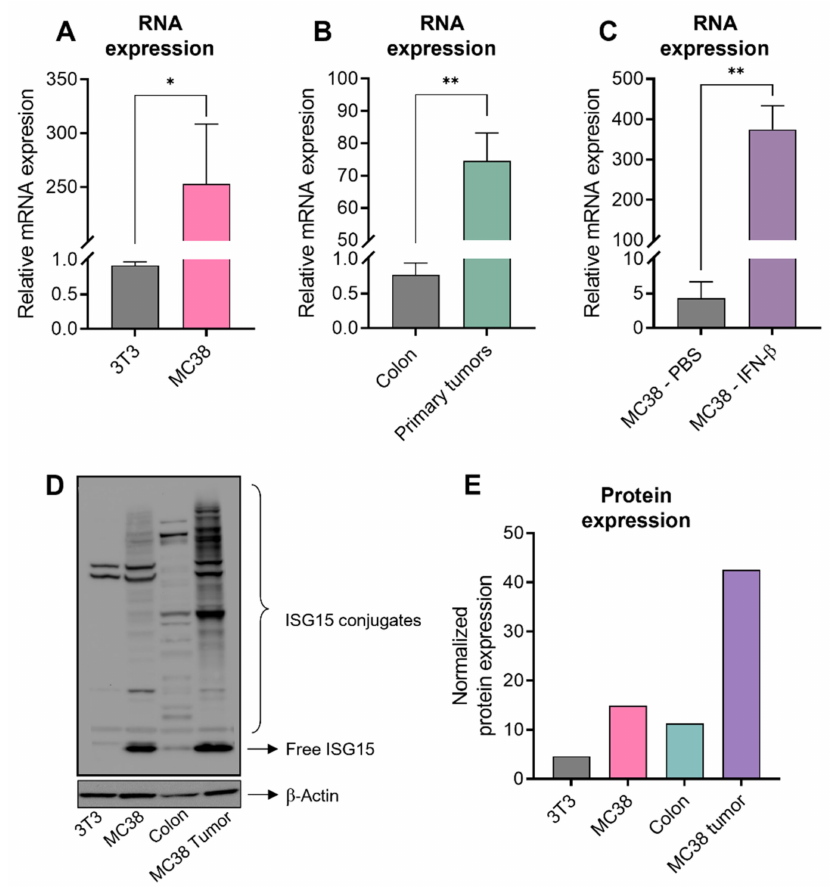
Figure 2. Elevation of ISG15 expression in murine CRC models. ISG15 mRNA expression relatively compared to 18S rRNA in ( A ) 3T3 vs. MC38 cell lines, and ( B ) colon tissues compared to MC38 subcutaneous tumors. ( C ) ISG15 is further induced in MC38 by 24 h exposure to IFN- β . ( D ) Western blot with ( E ) quantification demonstrating ISG15 expression and ISGylation in 3T3, MC38 cell line, colon tissues, and MC38 subcutaneous tumors. Data were analyzed using unpaired t -test. All error bars are shown as mean ± SEM. * p < 0.05, and ** p <